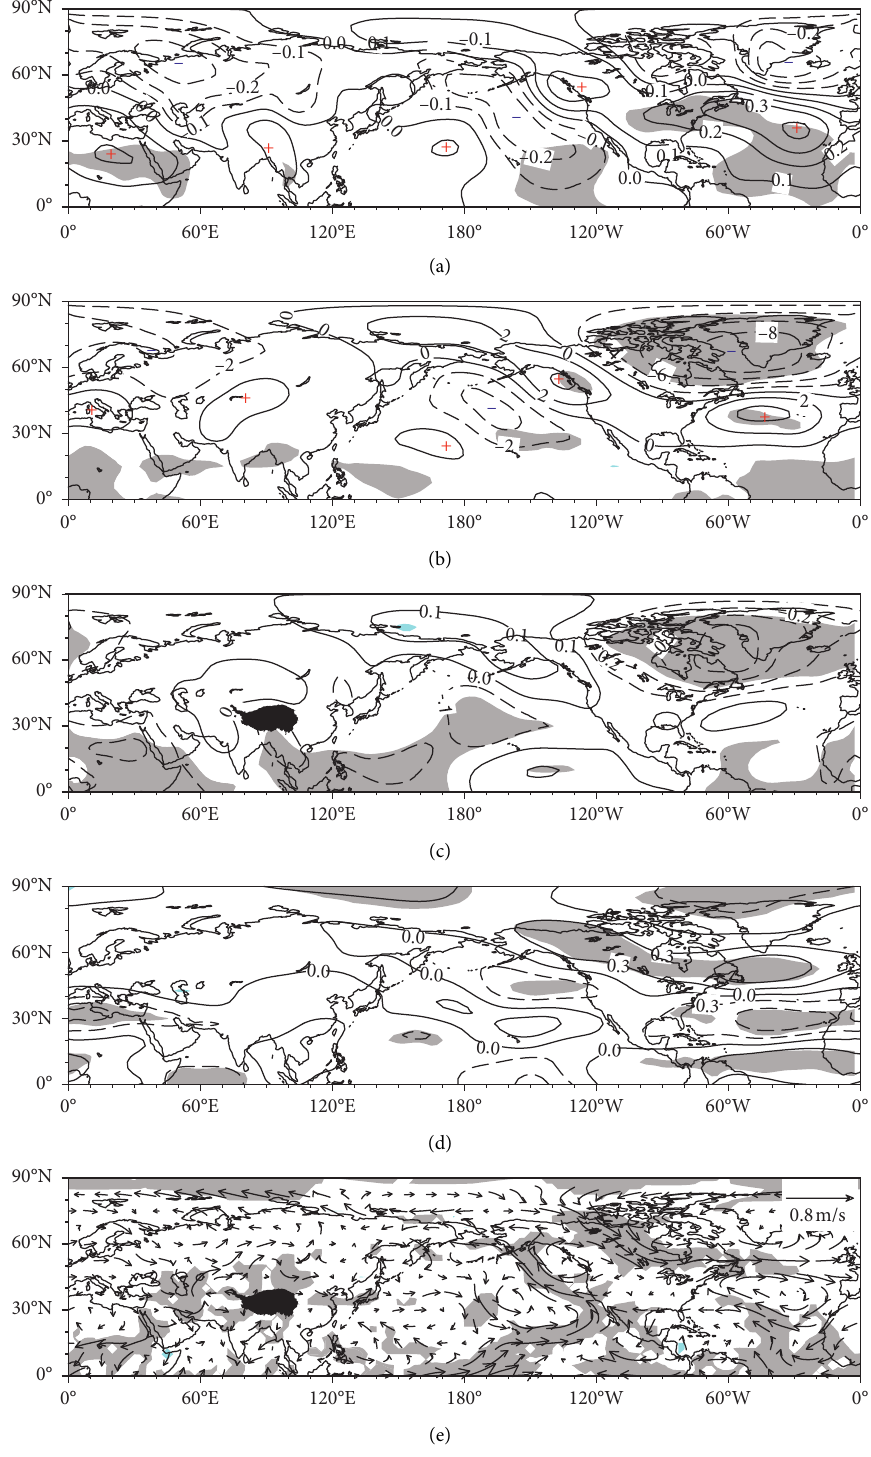
Figure 10: The same as in Figure 7 but for I